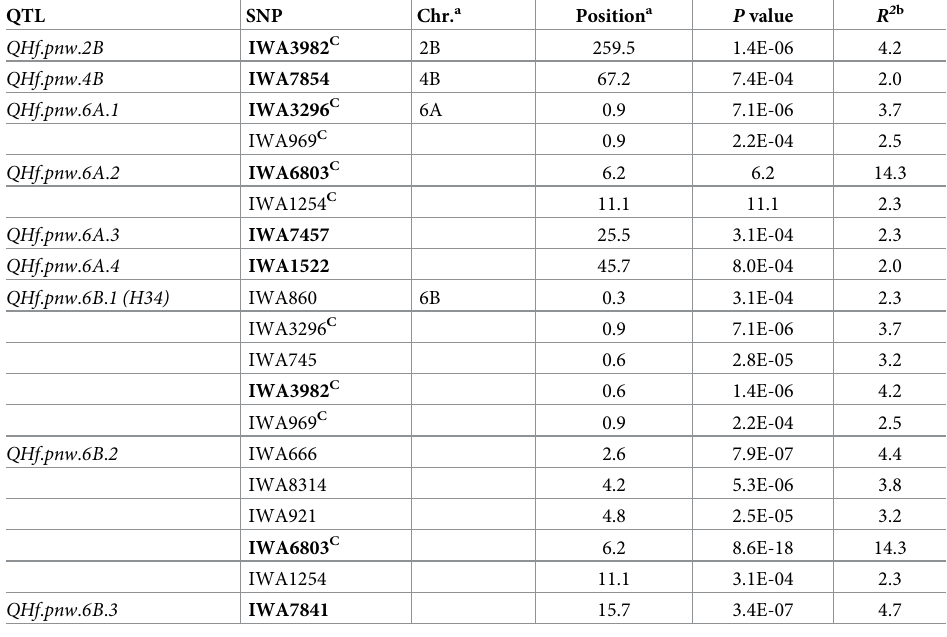
Table 4. Quantitative trait loci (QTL), QTL tagging SNP, chromosome location, P and R 2 values for UI Hessian fly population. QTL SNP Chr. a Position a P value R 2